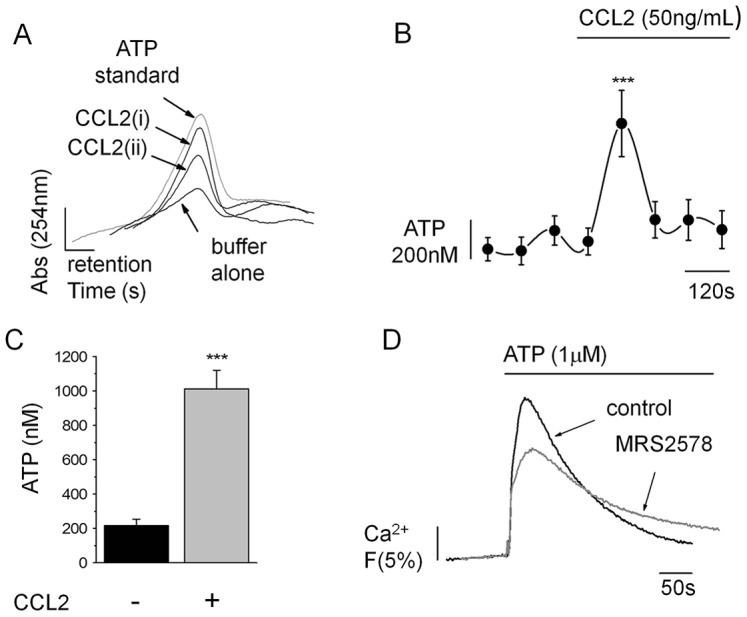
CCL2-coupled ATP secretion. (A) CCL2-stimulated ATP secretion from THP-1 cells detected by HPLC. Representative traces show HPLC analysis of THP-1-conditioned buffer following no stimulation (buffer alone) or collected immediately after (CCL2 i) or 2 min after (CCL2 ii) CCL2 (50 ng/ml) stimulation. Peak retention and amplitude are shown in comparison to a 1 µM ATP standard. (B) ATP content in THP-1-conditioned buffer collected before and after CCL2 (50 ng/ml) stimulation as quantified by luciferase bioluminescence (n = 7 for each time point). (C) Mean peak ATP secreted following CCL2 stimulation quantified by luciferase bioluminescence (n = 7). (D) Representative traces showing the suppression of the Ca2+ response evoked by 1 µM exogenous ATP following P2Y6 receptor inhibition (MRS2578, 1 µM). Fluo-4 signals are normalised to the maximum Ca2+ response elicited by 40 µM digitonin. ***P<0.01 (ANOVA). Data are presented as mean±s.e.m. All antagonists were pre-incubated for 30 min prior to agonist challenge.